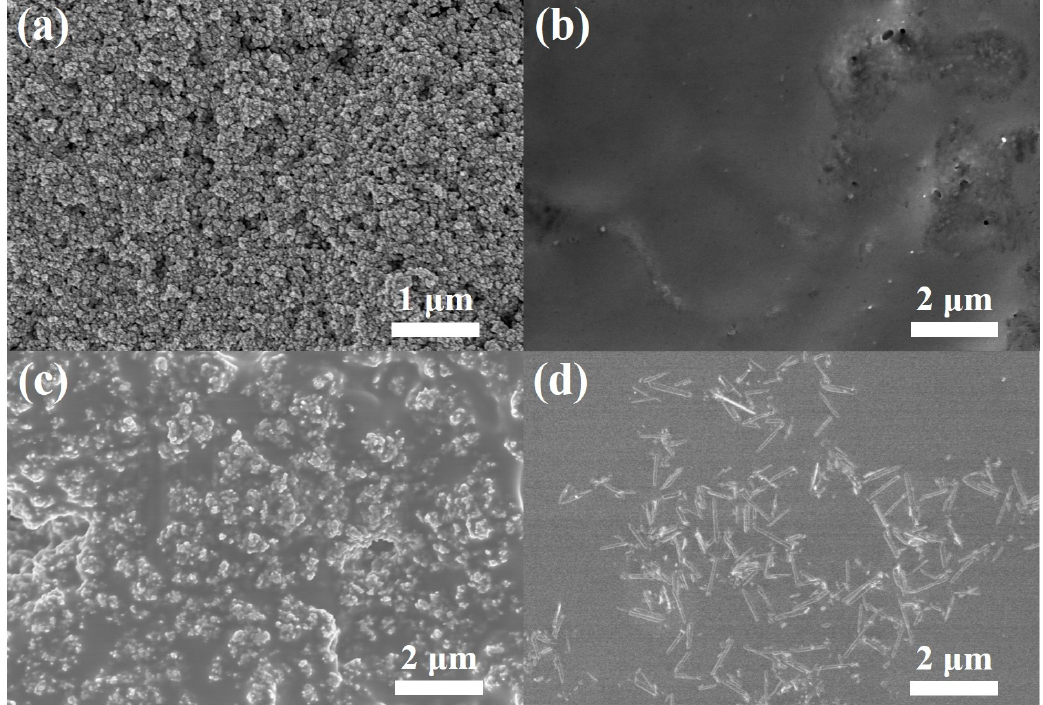
Figure 3. SEM image of the ( a ) photoanode, ( b ) photoanode after quasi solid-state electrolyte casting, ( c ) photoanode after commercial TiO 2 hybrid solid-state electrolyte casting and ( d ) photoanode after 1D TiO 2 hybrid solid-state electrolyte casting.